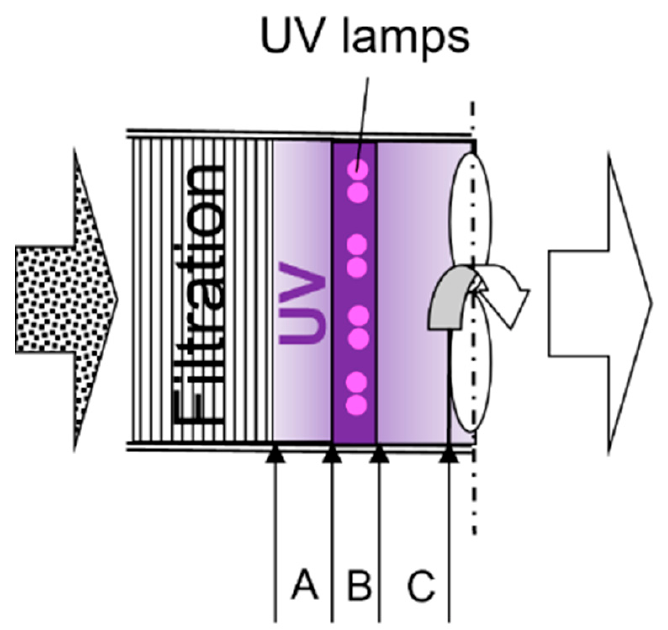
Figure 3. The schematic of UV irradiation inside the FastAir prototype. The filtered air entered three UV treatment zones, A, B, and C (upstream from lamps, in the near vicinity of lamps, and downstream of lamps).